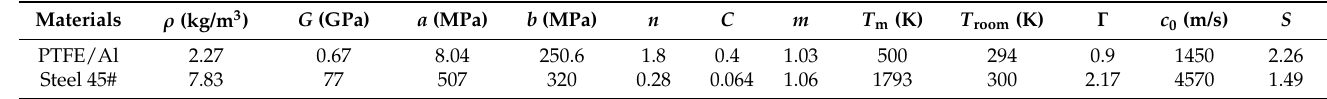
Table 2. Main parameters of the unreacted PTFE/Al reactive materials and steel